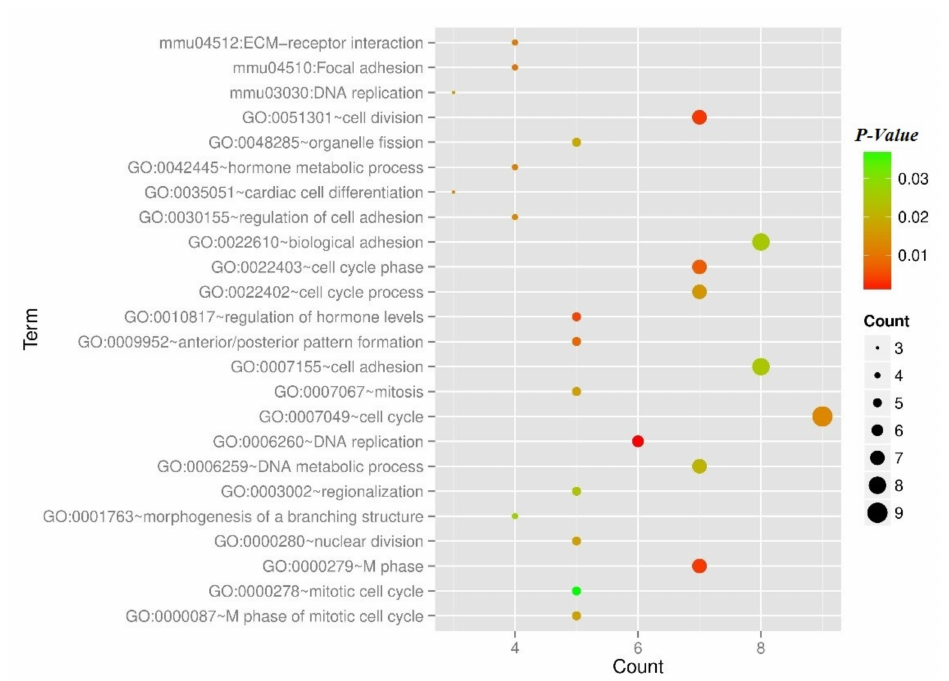
Figure 6. The scatterplot of the category of enriched GO terms and KEGG pathways for the DEGs in the co-expression network. Node size means gene count, color means p -value. Table 3. Enriched GOs and KEGG pathways for co-expression network